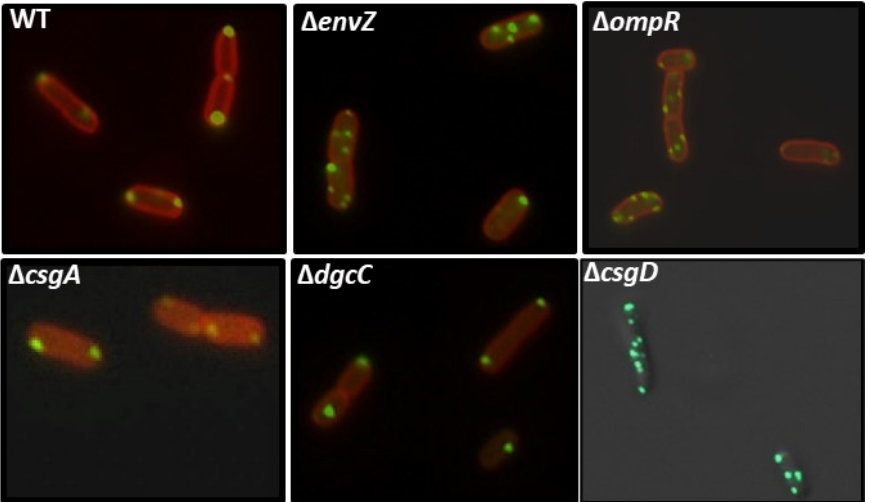
Figure 8. Curli fimbriae formation and YccT localization in various deletion mutants. Localization of YccT ‐ sfGFP in each deletion strain. The wild ‐ type (WT) strain or strains with a deletion of envZ ( Δ envZ ), ompR ( Δ ompR ), csgA ( Δ csgA ), dgcC ( Δ dgcC ), or csgD ( Δ csgD ) were transformed with pBADyccT ‐ sfGFP and grown in LB medium in the presence of 0.02% (final concentration) arabinose at 37 °C for 2 h. The membranes of the E.coli cells (except that of the Δ csgD mutant) were stained with FM4 ‐ 64.